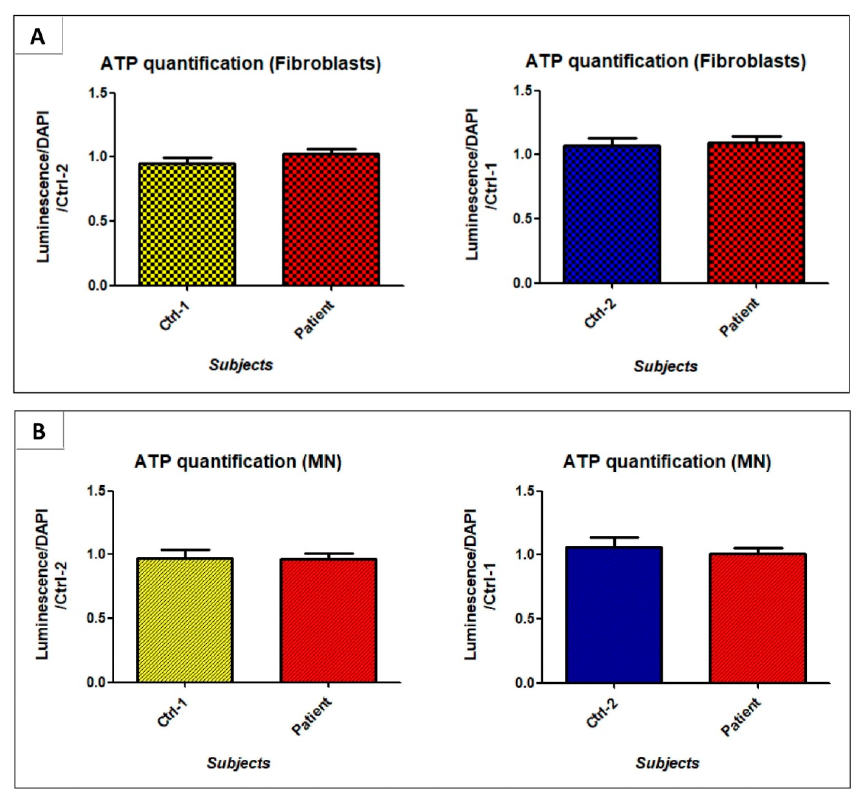
Figure 11. ATP production evaluated in fibroblasts ( A ) and MNs ( B ) of Ctrl-1, Ctrl-2, and patient.